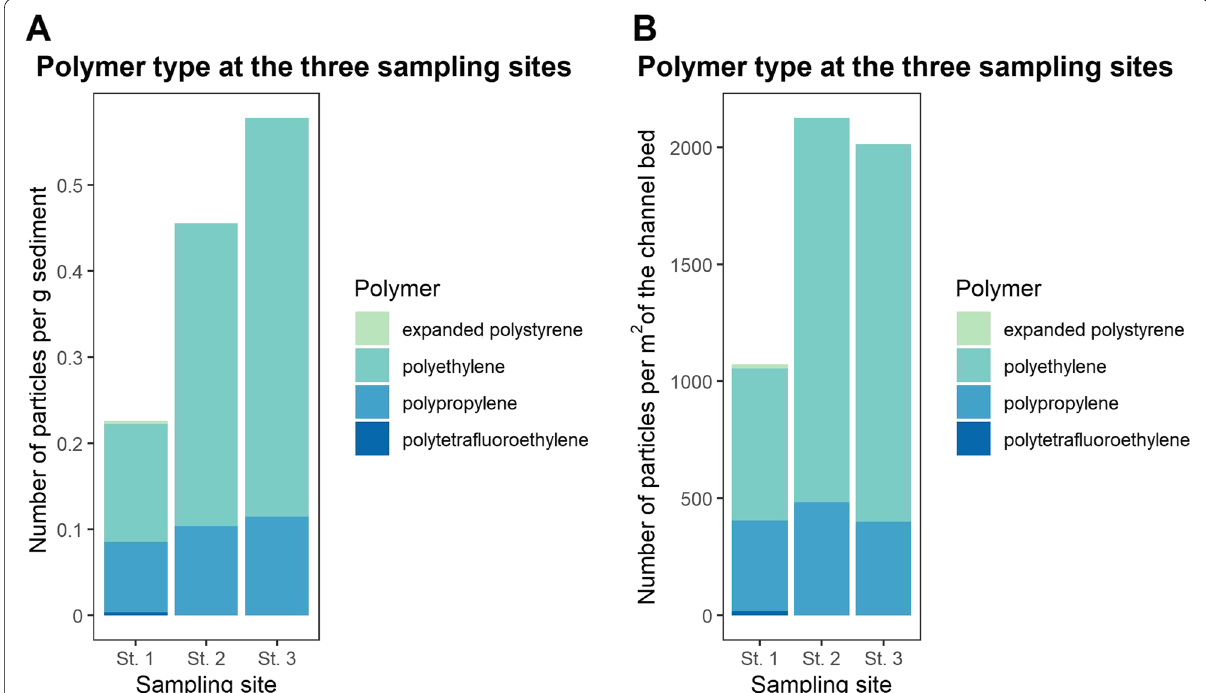
Fig. 3 Concentrations of expanded polystyrene, polyethylene and polypropylene at the three sites reported as A microplastic particles per g sediment and B microplastic particles per m 2 channel bed